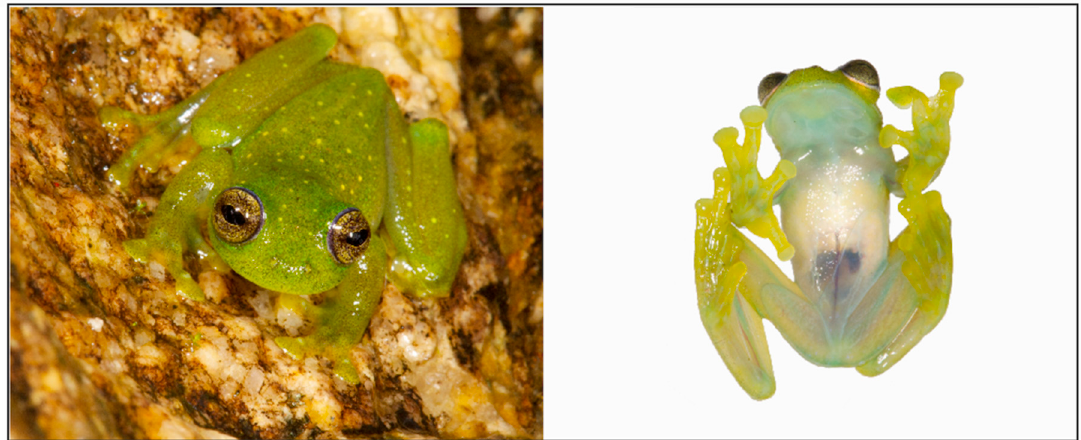
Figure 190. Rulyrana flavopunctata in life. Ecuador, Napo province, Cordillera de los Guacamayos, 1564 m, MZUTI 1250 ( left ), 1260 ( right ). Photos by Eduardo Toral. Diagnosis: (1) Teeth on vomers present or absent; each vomer with zero to three teeth; (2) snout usually rounded in dorsal and lateral views; (3) tympanum visible, its diameter 27.9%–38.7% of eye diameter; supratympanic fold low; (4) dorsal skin shagreen; males with spicules; (5) skin of venter areolate; pair of slightly enlarged subcloacal warts; (6) anterior half of ventral parietal peritoneum white, posterior half translucent (condition P2); pericardium white; peritonea covering intestines, stomach, and kidneys lacking iridophores; urinary bladder transparent (condition V1); (7) lobed liver lacking iridophores (condition H0); (8) humeral spines absent; (9) webbing between Fingers I and II absent or basal, moderate between Fingers II and III, extensive between Fingers III and / 2 + / 3 + / 2 − − IV; webbing formula for outer fingers: II (1 1 –2 )—(3–3 ) III (1 1 –2 )—(1 –1 1 ) IV; (10) feet